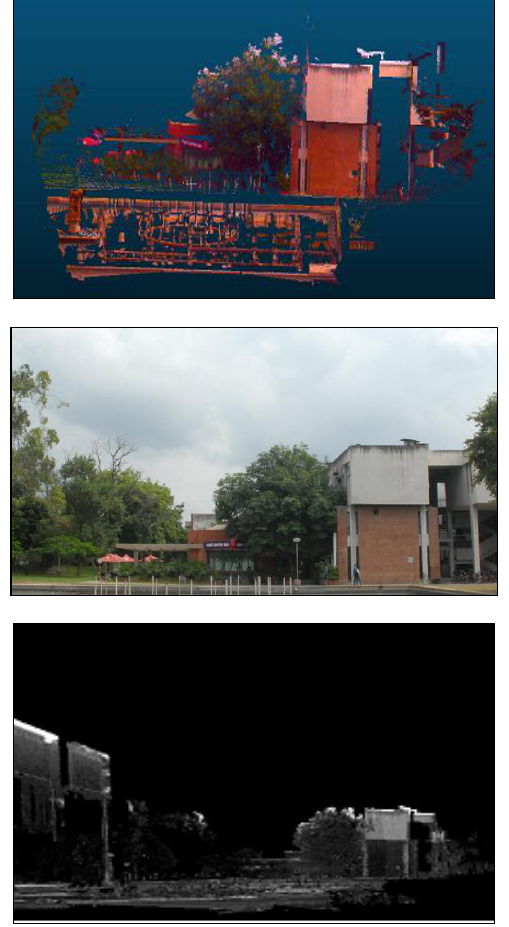
Figure 3. LiDAR scanned data (top), camera image taken by user (middle) and corresponding intensity image (bottom)